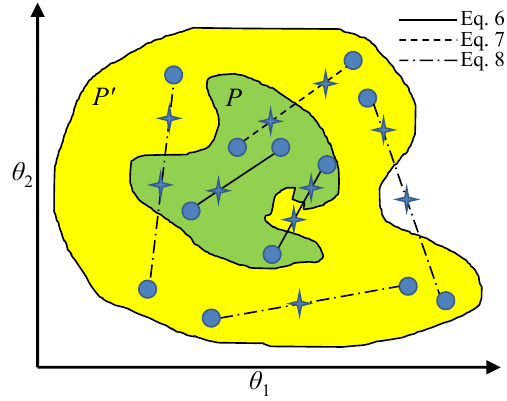
Figure 2. A conceptual illustration of possible positions of newly generated parameter sets based on parameter sets randomly drawn from P and P (cid:48) for a two dimensional parameter space. The area indicated in yellow represents the set P (cid:48) that satisfies exactly C − f − 1 to C − 1 process based constraints. The area indicated in green represents the set of P that satisfies C or more process constraints. The circles indicate randomly selected parameter sets drawn from the sets P or P (cid:48) . Different line styles indicate differ- ent parameter generation rules (corresponding to the different equa- tions). Solid lines represent the first rule, where the parameter sets are randomly selected from set P (Eq. 6); dashed lines illustrate the second rule, where one parameter set is randomly selected from P and one from P (cid:48) (Eq. 7); the dash-dot line represents the third rule, where both randomly selected parameter sets are selected from set P (cid:48) (Eq. 8). Note that due to possible non-convexity of sets of P and P (cid:48) the newly generated parameter sets based on the three rules can be outside of sets P and P (cid:48)